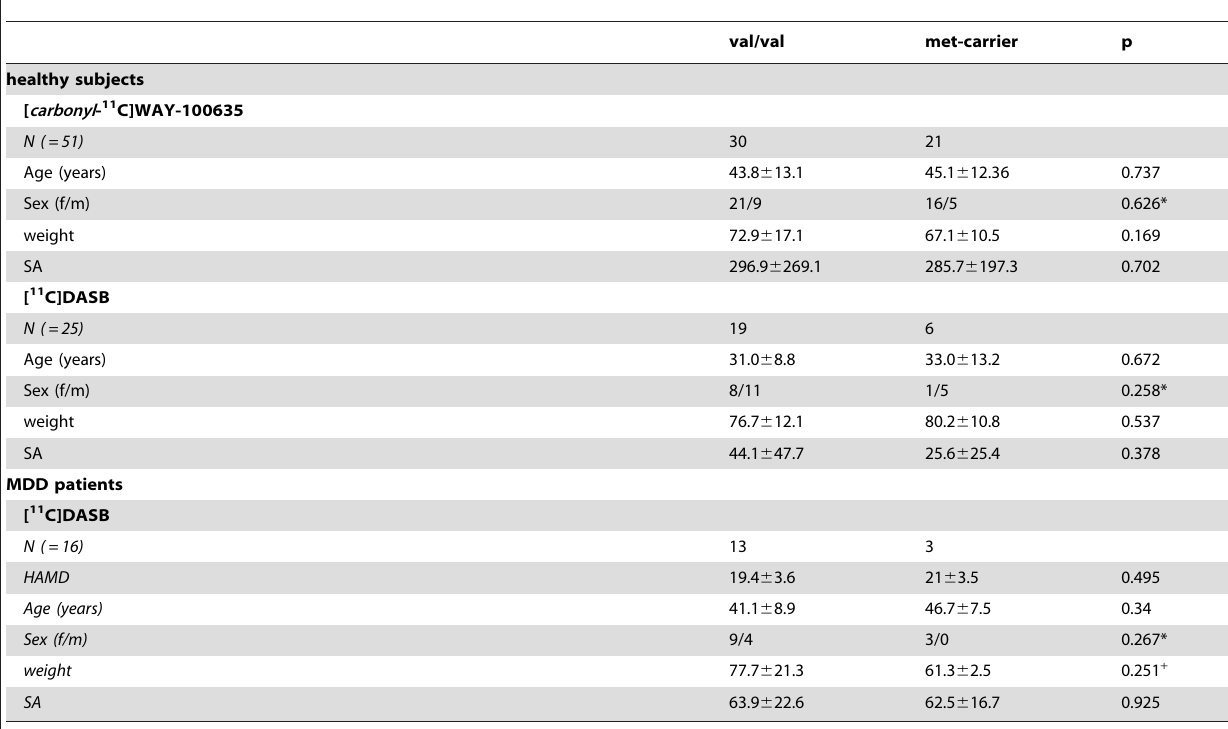
Table 1. Demographic variables of the entire study